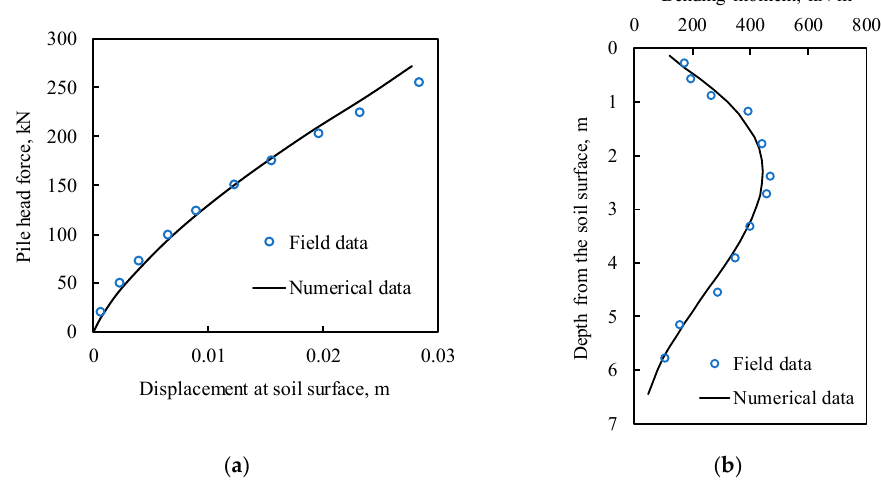
Figure 4. Comparison of numerical results and field test data with a lateral load 272.16 kN: ( a ) load–displacement curve and ( b ) bending moment.